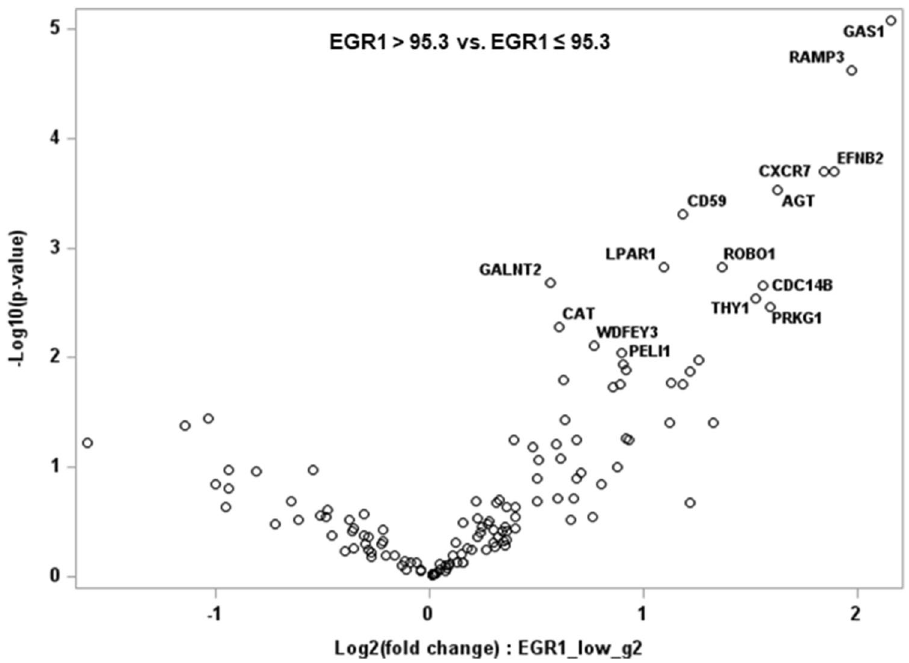
Figure 3. Volcano plots show the distribution of the fold changes in gene expression based on EGR1 expression. Genes with absolute fold change ≥ 2 and the most statistically significant genes ( P < 0.01) are listed.